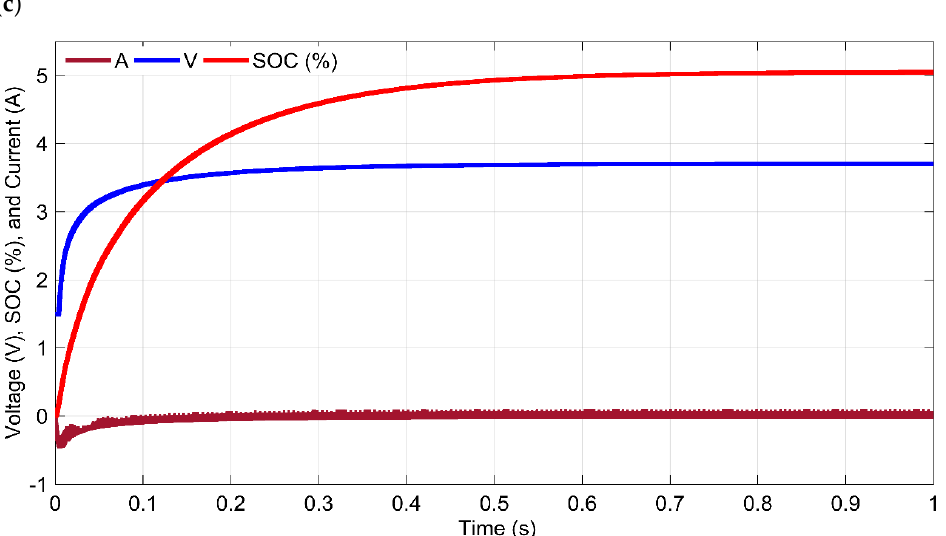
Figure 10. Simulation results ( a ) hybrid output curve of the proposed system; ( b ) boost converter output curve; ( c ) the SC output voltage, current and SOC (%).